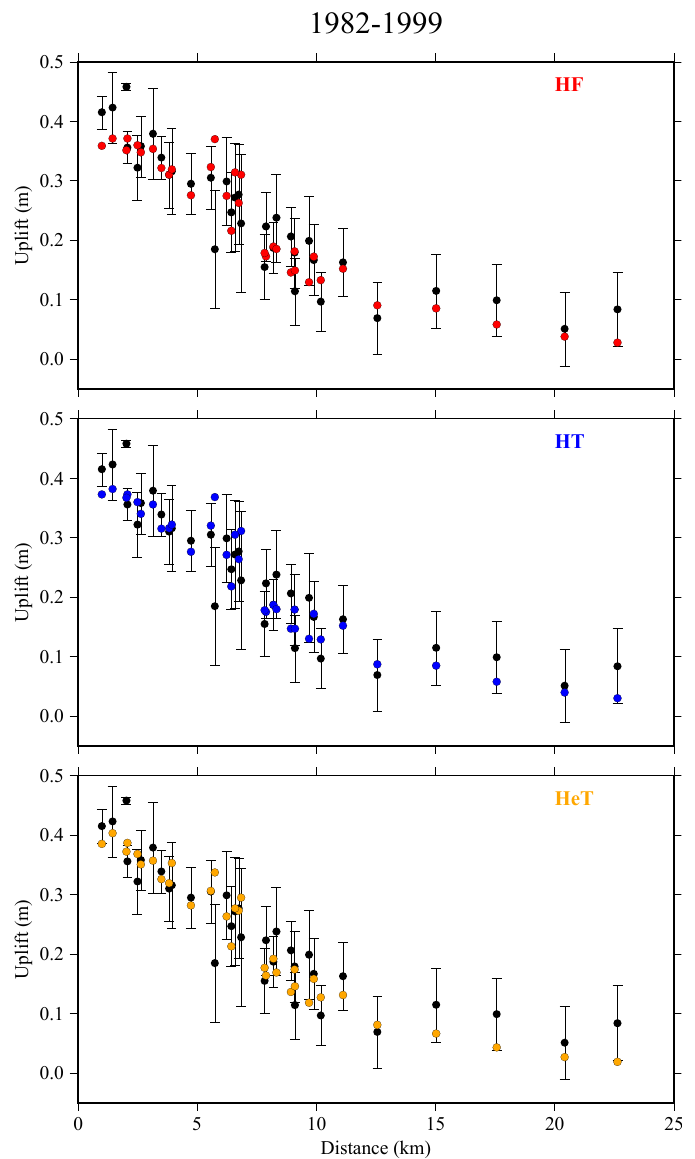
Figure 10. Comparison between observed (black circles with 1-sigma error bars) and modeled (colored circles corresponding to different model configurations) uplift at leveling benchmarks for the data in 1982–1999 ordered according to the horizontal distance from the resurgent dome center. HF: homogeneous flat crust; HT: homogeneous crust with topography; HeT: heterogeneous crust with topography.